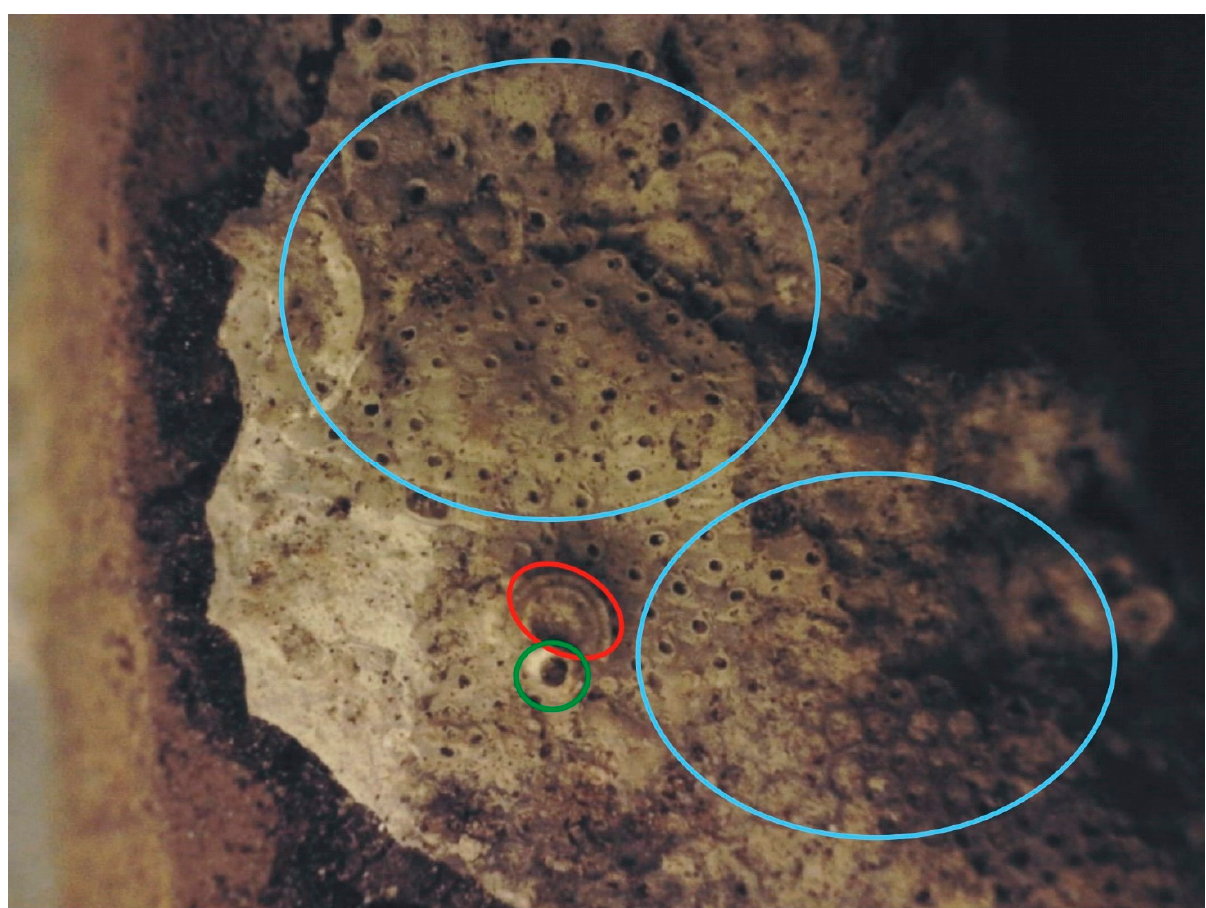
Figure 2. Example of marine organism shells developed on some Kyrenia ceramics. Circled in blue—zones with calcareous skeletons of Bryozoans, circled in red—calcareous tube of sea worm (Polychaetes), and circled in green—conical calcareous shell of Barnacle (Mauro La Russa, pers. com.).